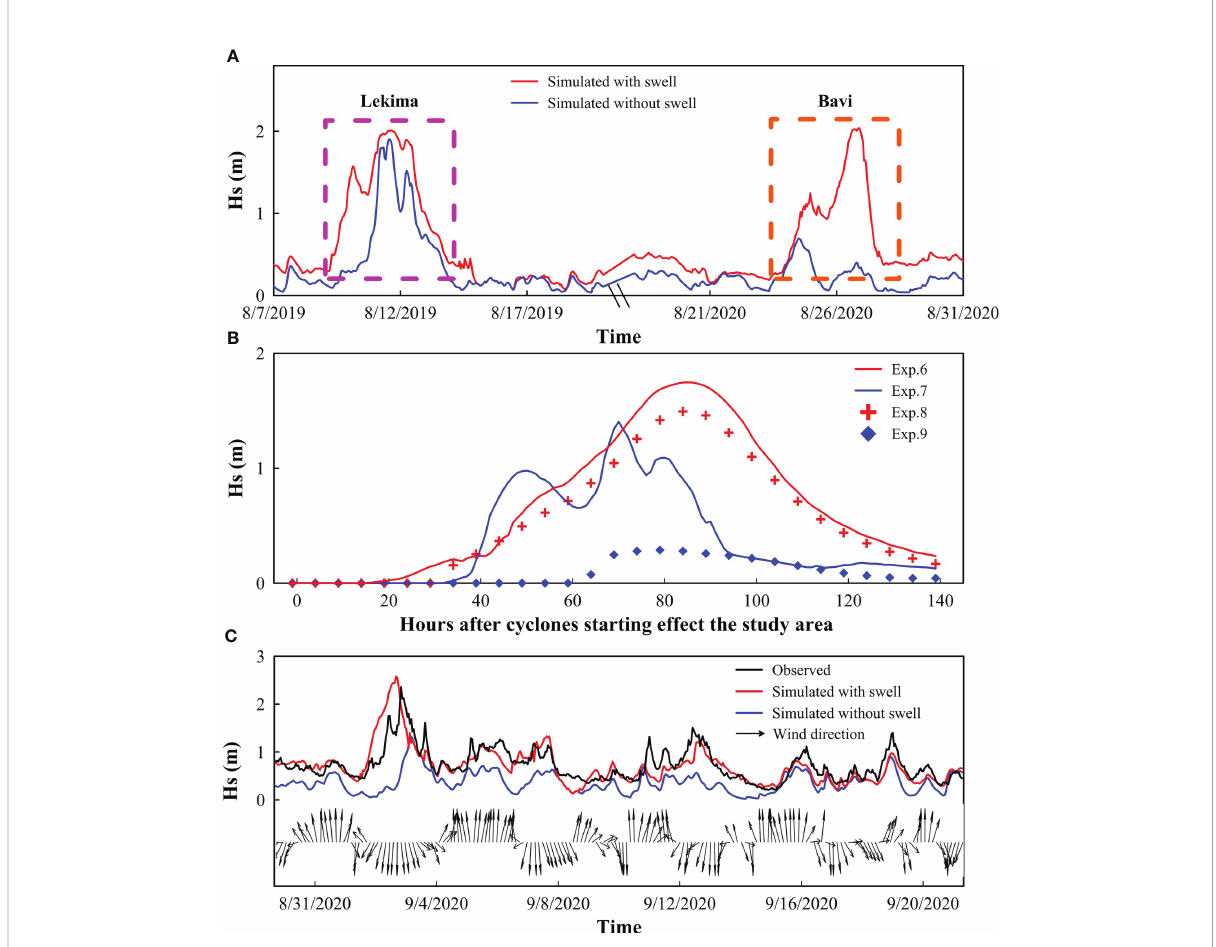
FIGURE 8 Comparisons of the simulated signi fi cant wave heights with/without swell at Station C2 during Lekima and Bavi (A) and driven by ideal wind in Exp.6 to Exp.9 (B) , respectively. Comparisons between the observed and simulated signi fi cant wave heights with/without swell at Station W, and the time serious of wind directions (black arrows) were obtained from CFSv2 (C) . The purple dotted rectangular box represents the period of Lekima, and the orange one represents the period of Bavi in panel (A) .